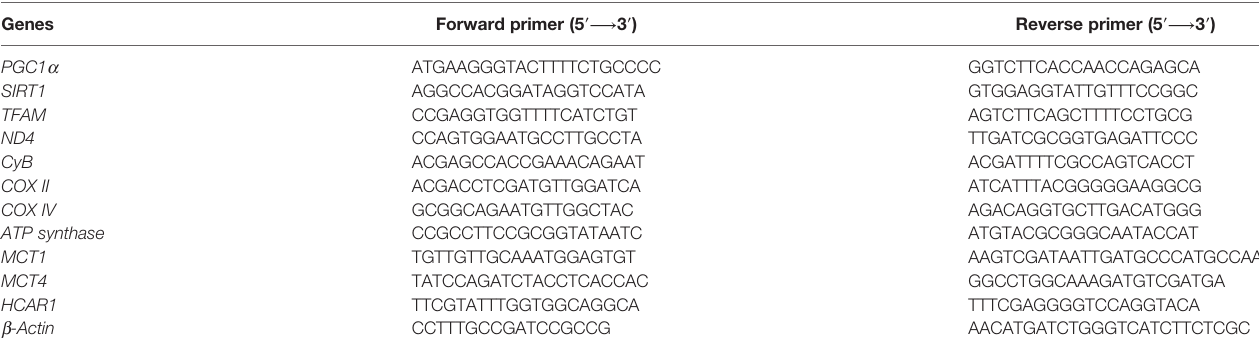
TABLE 1 | Genes of interest.